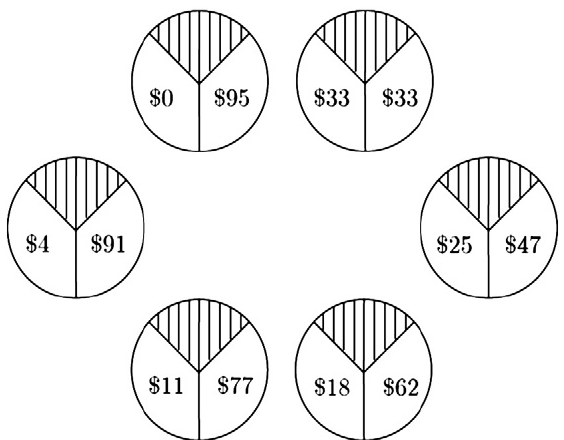
Figure A2. Lottery choices in the ambiguity game. The game is based on [46]. Values are in 2014 BRL. This game intends to capture baseline attitudes towards risk. Subjects choose one of six lotteries. As one moves clock-wise around the ring, the lotteries increase in risk and expected payoff except for the last lottery, which has the same expected payoff as the fifth but is riskier. The participant knows that there are at least three low value balls and three high value balls in each circle but does not know the distribution of the remaining four balls which could be either low or high value. Thus, the odds of a high or low payment are bounded between 30% and 70% but are unknown. To determine payouts for the task, participants first choose one lottery to play. A computer then draws the outcome.